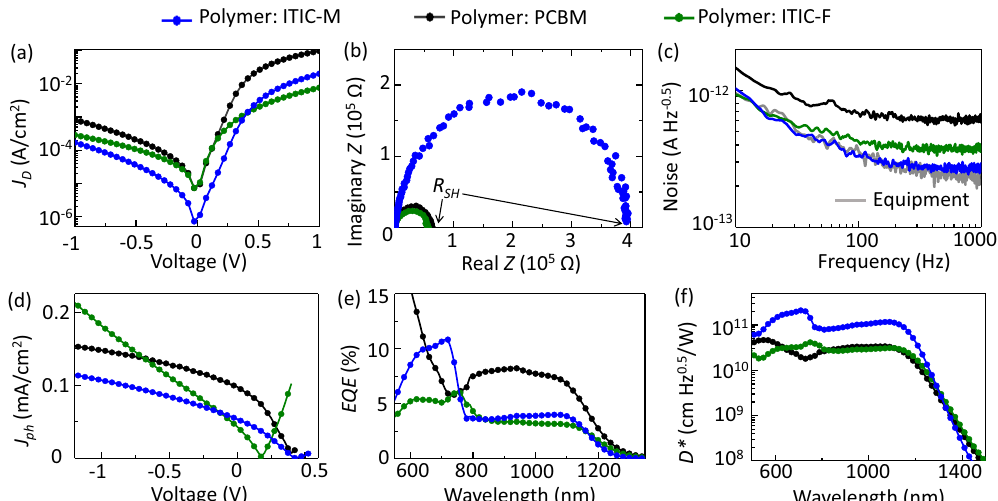
Fig. 2 Characteristics of the organic infrared photodiodes. a Dark current density versus applied voltage. b Imaginary versus real impedance. c Noise current density measured by a power spectrum analyzer. The equipment background noise is included as the gray line. d Photocurrent density versus voltage measured under a 1.2 mW/cm 2 continuous light with λ = 1100 nm. e External quantum ef fi ciency and f speci fi c detectivity measured under a monochromatic light modulated at 400 Hz. The devices in b , c , e , and f are biased at 0